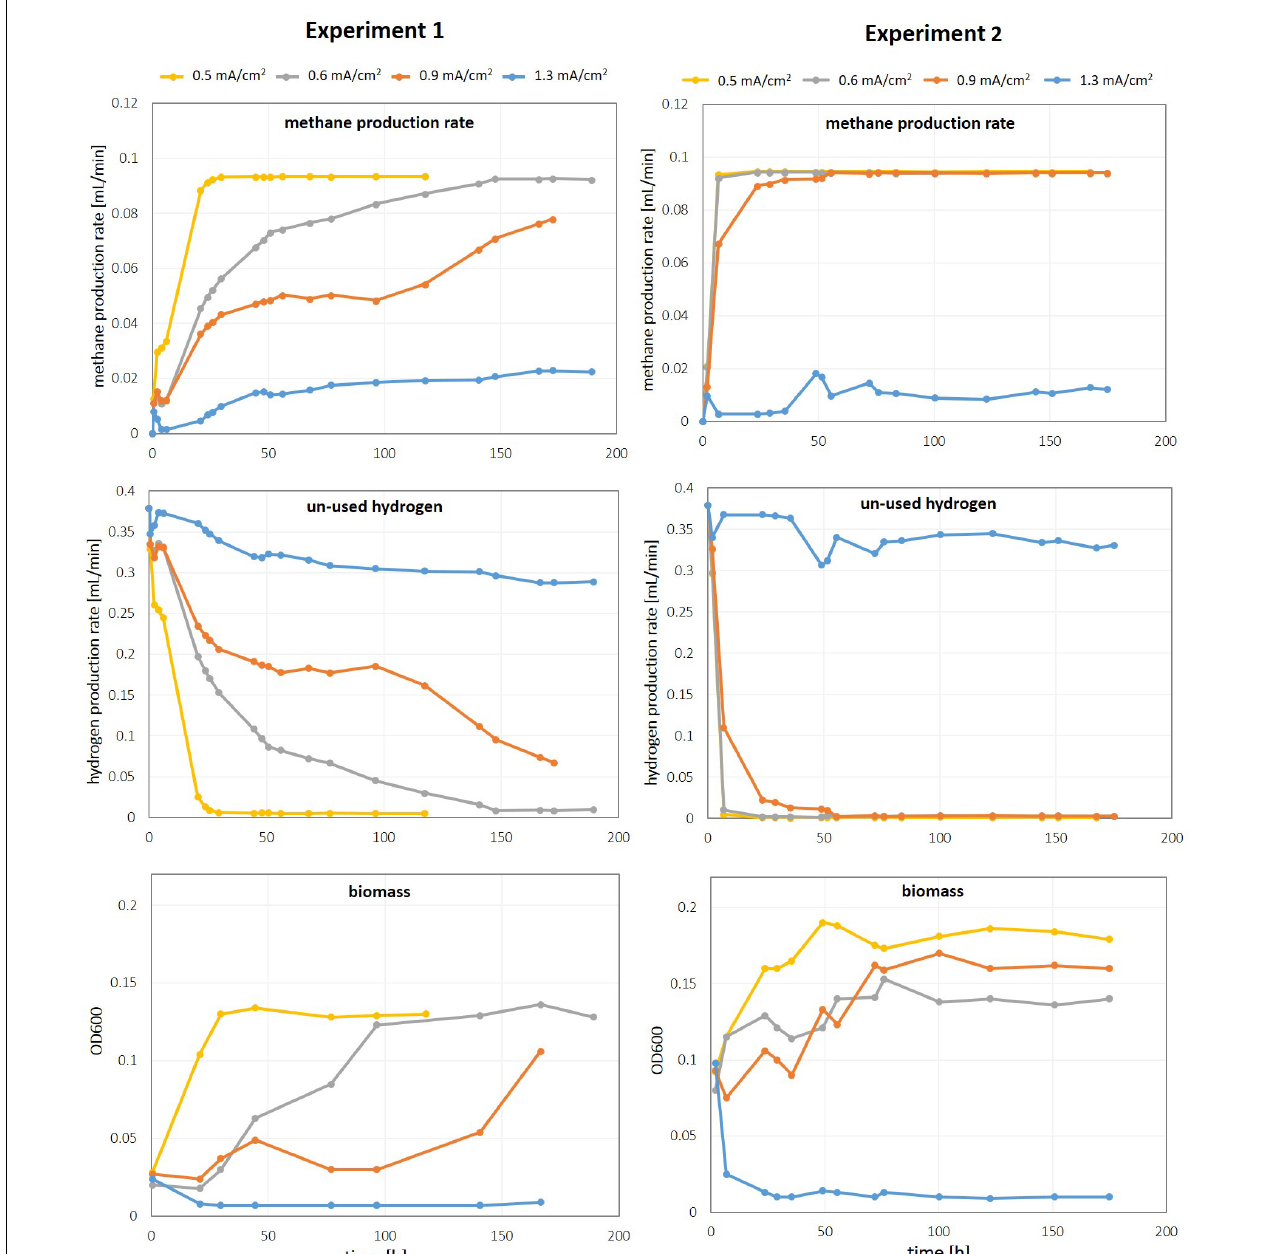
FIGURE 2 | Methane production rate, unused hydrogen in the reactor off gas and microbial growth during Exp1 (initial OD = 0.02, left column) and Exp2 (initial OD = 0.1, right